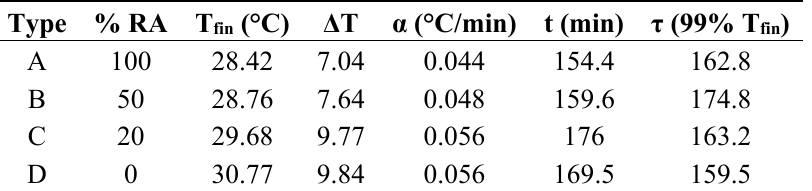
Table 4. Thermography results for each specimen